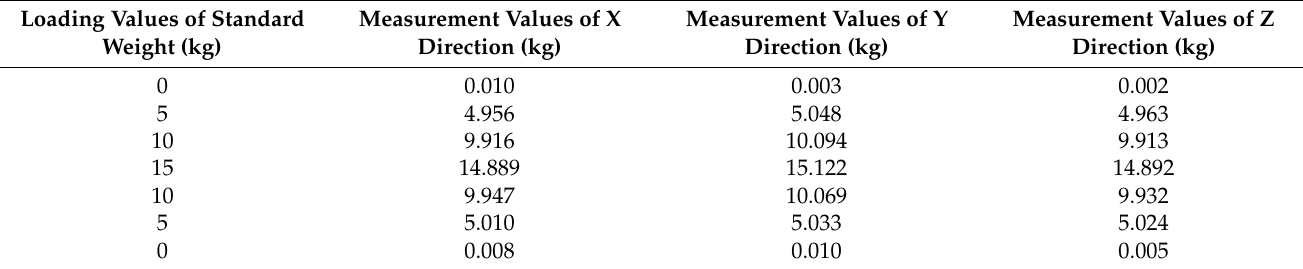
Table 2. Calibration and validation of the wind tunnel measuring system.